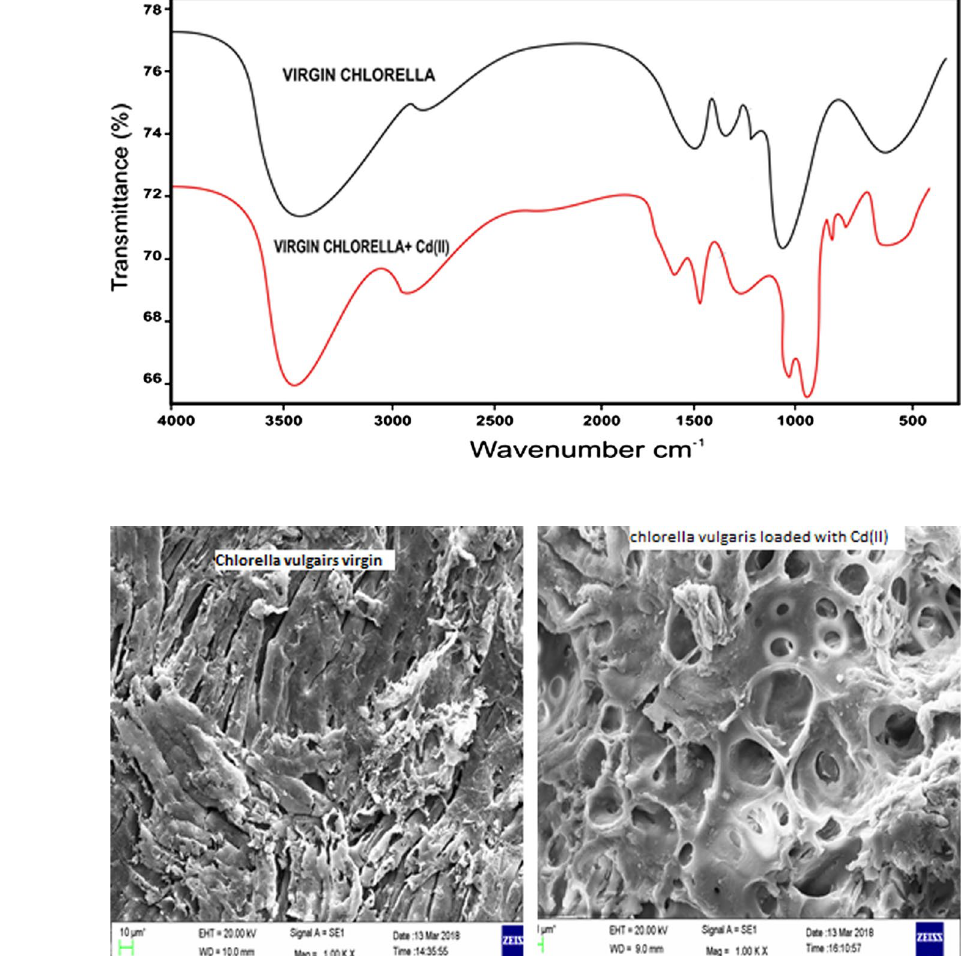
Fig. 2 FTIR spectra of virgin chlorella and loaded with Cd (II) metal ions